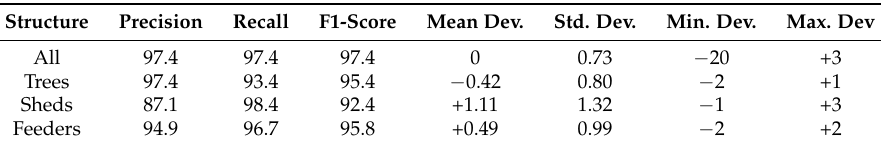
Table 3. Results for images containing different types of structures.